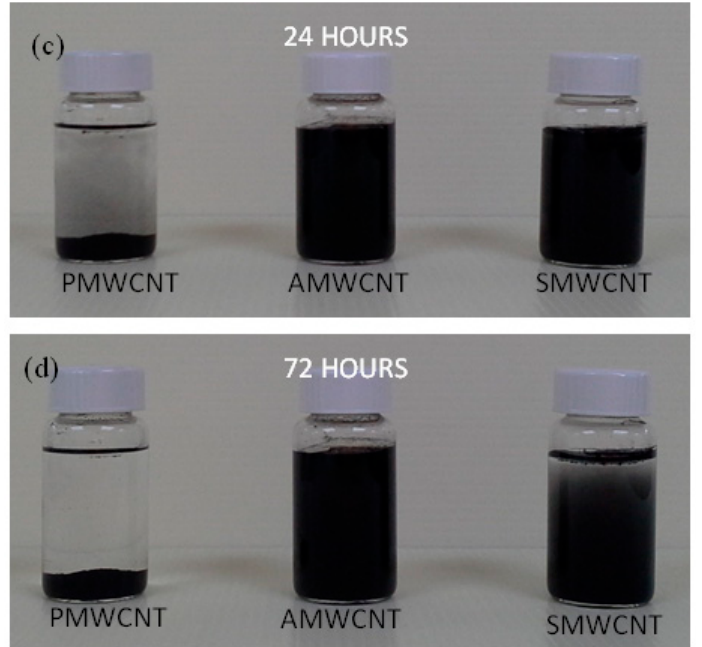
Figure 2. Digital images of MWCNT dispersion in ethanol after: ( a ) 30 min, ( b ) 12 h, ( c ) 24 h, and ( d ) 72 h.